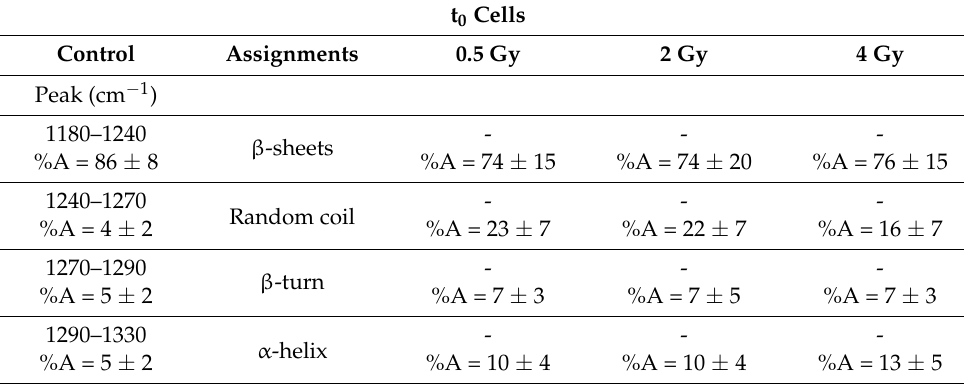
Figure 3. Variations of secondary protein structure contributions to Amide III band (1350–1180 cm − 1 ) with dose, for cells fixed immediately after irradiation; the ratios between the secondary structure peak areas and the area of the entire Amide III peak are reported as Mean ± SD. Asterisks indicate when a significant difference with respect to the corresponding control value occurred at p ≤ 0.05. Table 4. Amide III deconvolution results for control and irradiated sample fixed immediately after irradiation, with assignments in accordance with the data reported in the literature [39,48]. The ratios between the area of the different subcomponents and the area of the entire Amide III band are reported as a mean value of percentage (A%) ± SD .